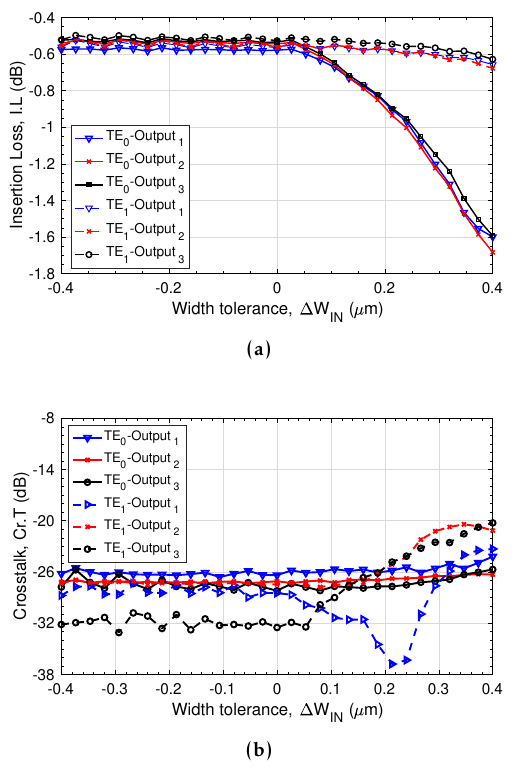
Figure 9. Insertion loss (a) and crosstalk (b) of the proposed switch as a function of the length tolerance of MMI